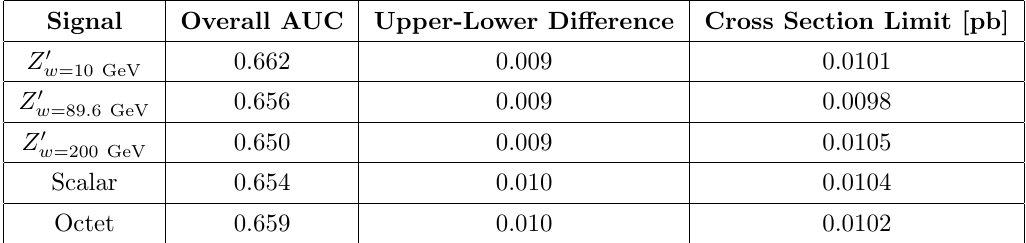
Table 1. The overall AUC score, di(cid:11)erence between the largest and smallest AUC scores and the cross section limits found from using the adversarial autoencoder trained only on background events and tested on the original Z 0 case and four other